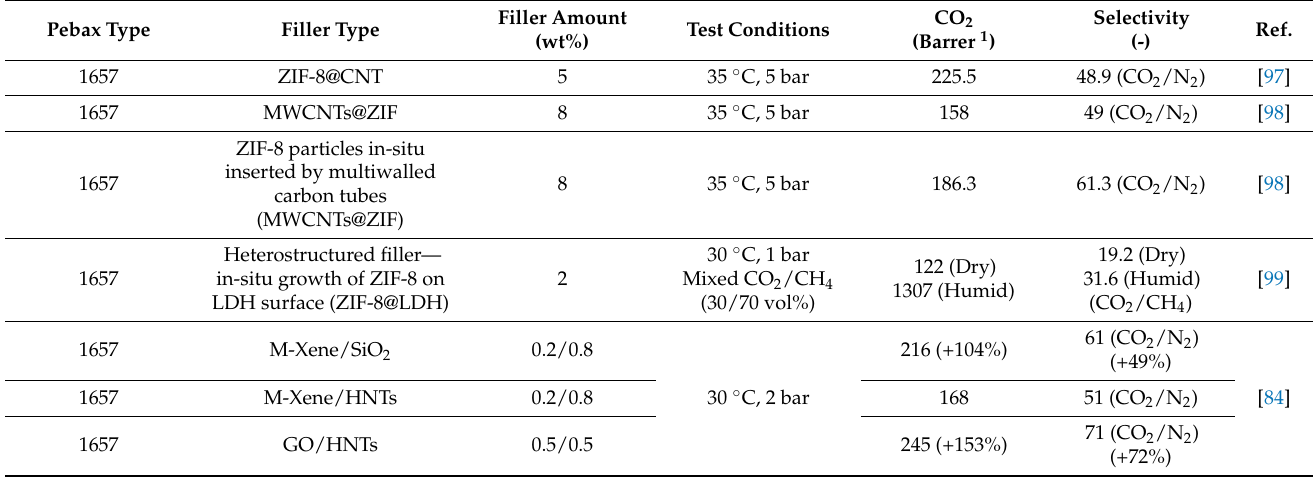
Table 10. Permeation properties of selected Pebax-based MMMs filled with combined fillers.